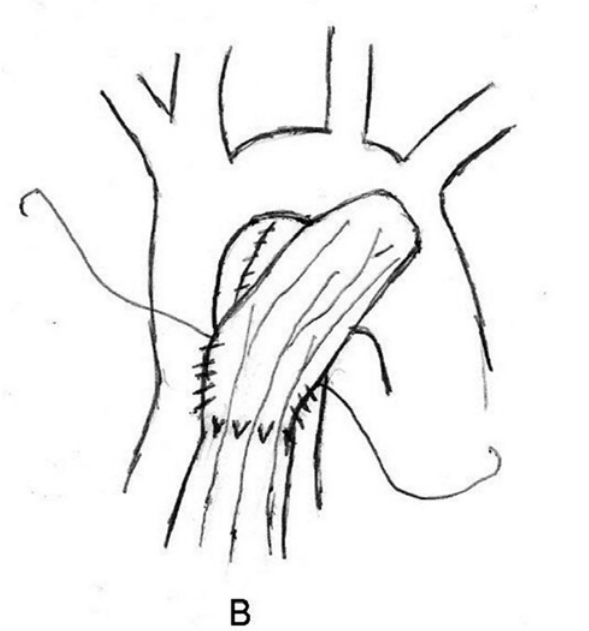
Fig. 4 - Implante de retalho pericárdico autógeno pediculado e vascularizado que vai crescer ao longo do tempo. Estes pacientes em geral são